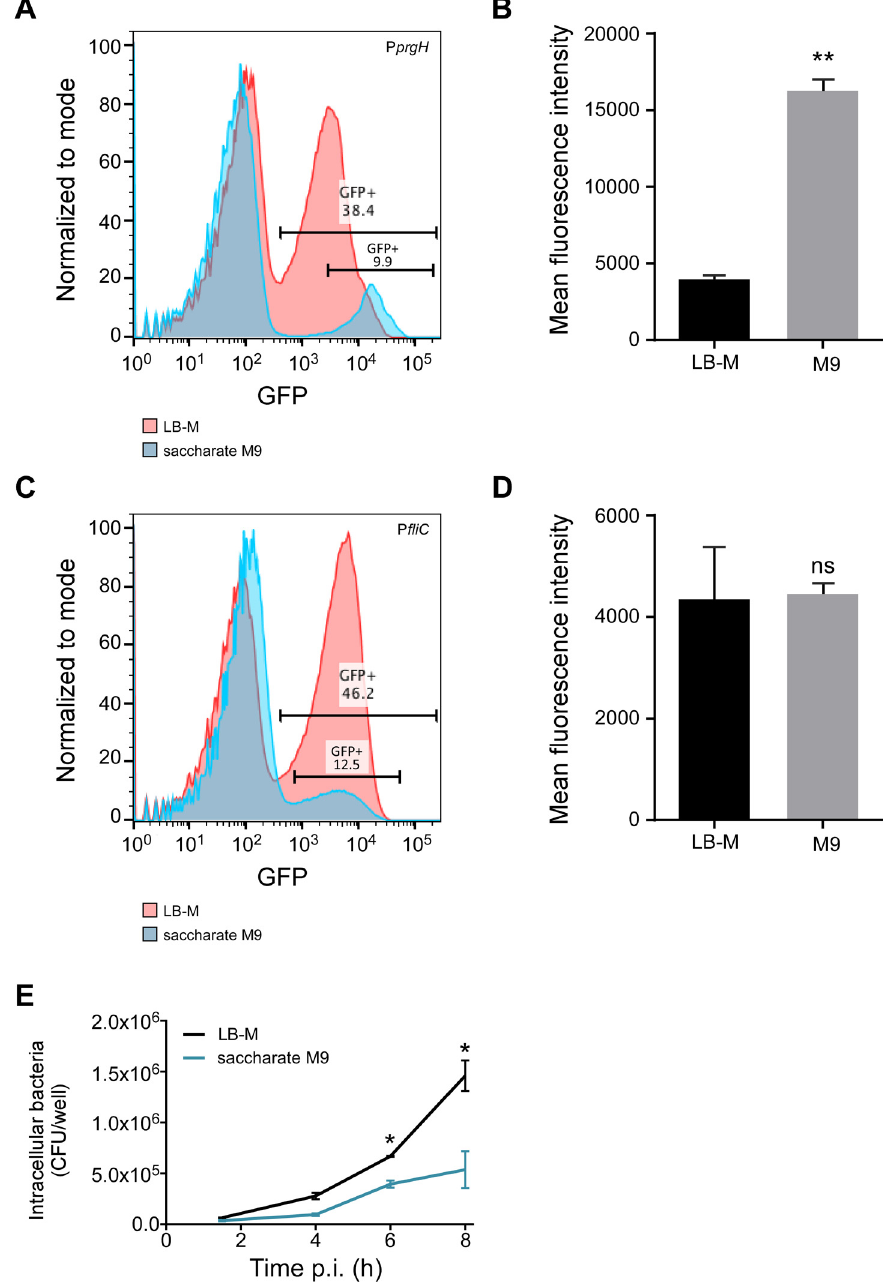
Fig 5. Intracellular replication of Salmonella Typhimurium in HeLa cells is determined by pre-invasion growth conditions. A, C. Flow cytometry from a single representative experiment showing GFP-intensity for the P prgH (A) and P fliC (C) reporter strains, grown in LB-Miller (red) or saccharate M9 (blue). B, D. MFI of gated GFP + bacteria for the P prgH (B) and P fliC (D) reporter strains. Data shown are mean ± SD, n = 3 ( * p < 0.05). E. Gentamicin protection assay showing intracellular replication of bacteria grown under SPI- 1-inducing conditions in LB-M or saccharate M9. Data shown are mean ± SD, n = 3. A two-way ANOVA with Tukey ’ s multiple comparisons test was